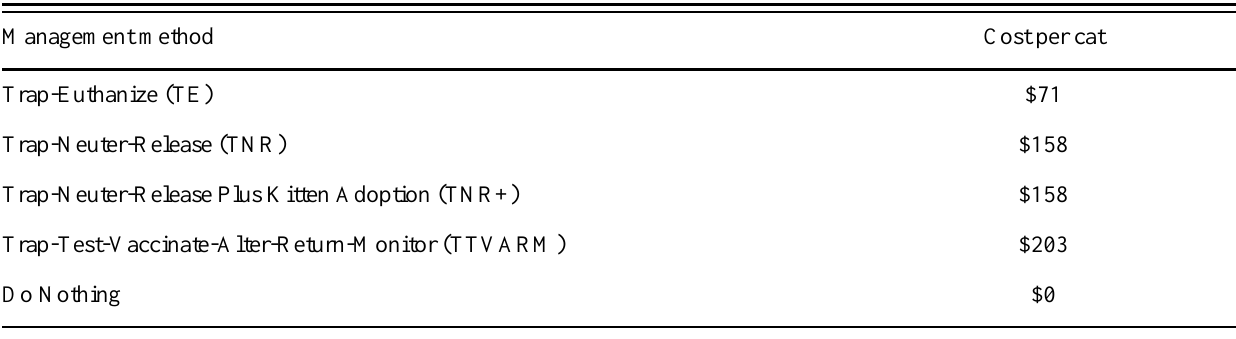
Table 4 . Cost per cat of each potential management method (cat capture, transfer and food cost to maintain colonies not included)